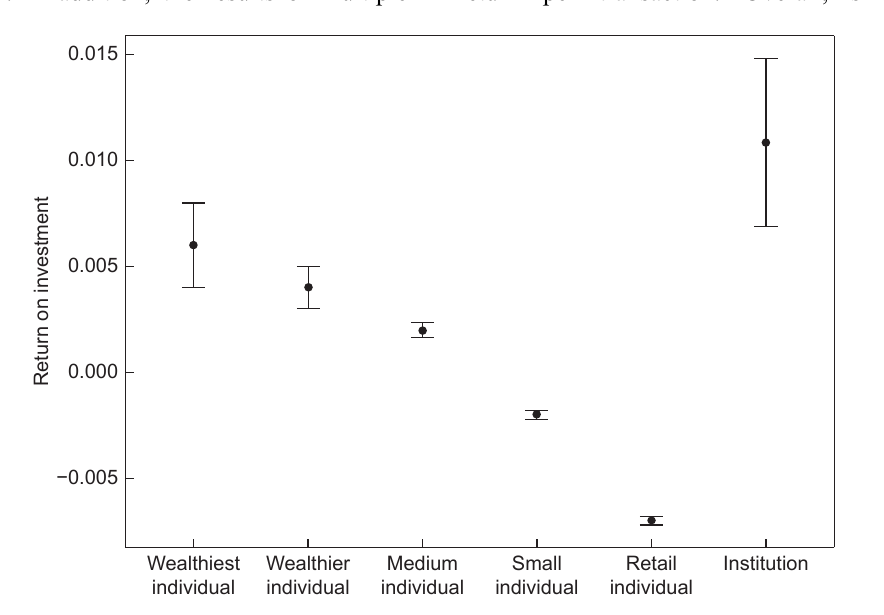
Fig. 1 Comparison of return for various types of